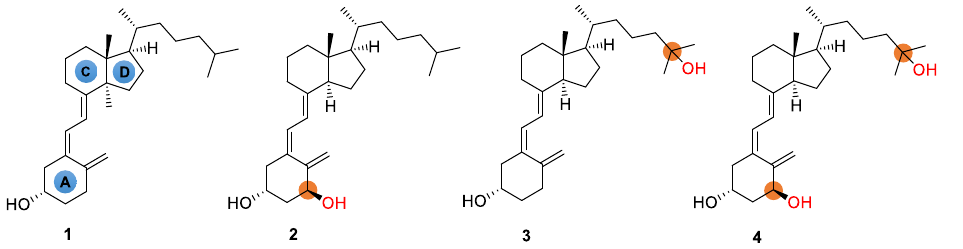
Figure 1. Chemical structures of vitamin D3 ( 1 ) and its active forms such as alfacalcidol ( 2 ), 25-hydroxyvitamin D3 ( 3 ), and calcitriol ( 4 ).